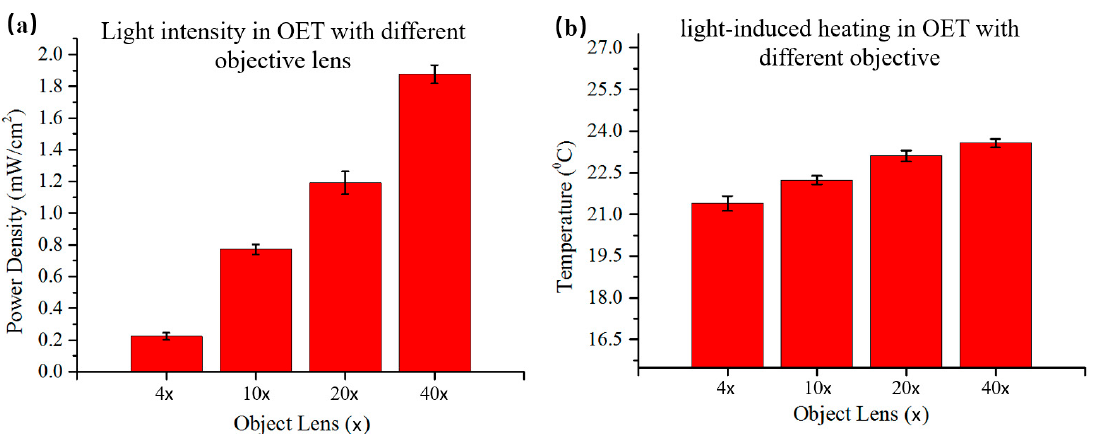
Figure 7. Light intensity and light-induced heating in OET with different objectives. ( a ) Optical power density measured with a square light pattern projected onto an OET device through 4 × , 10 × , 20 × , 40 × , or 60 × microscope objectives; ( b ) Temperature measured with a square light pattern projected onto an OET device under 4 × , 10 × , 20 × , 40 × , or 60 × microscope objectives.